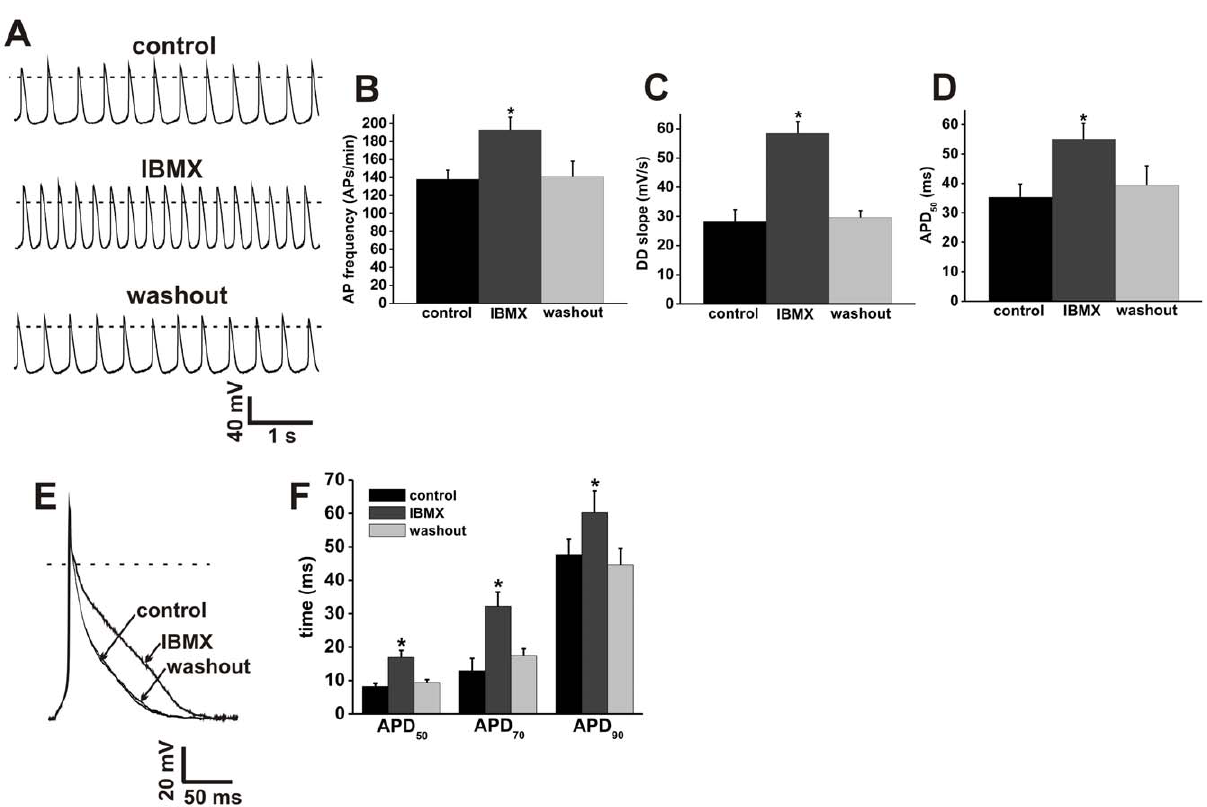
Figure 2. Effects of IBMX on action potential firing in SAN and atrial myocytes. A. Representative spontaneous AP recordings (5 s duration) in control conditions, in the presence of IBMX (100 m M) and after IBMX washout. Dotted lines are at 0 mV. Summary bar graphs illustrate the effects of IBMX on spontaneous AP frequency ( B ), DD slope ( C ) and APD 50 ( D ). E. Representative stimulated right atrial myocyte APs in control conditions, in the presence of IBMX (100 m M) and after IBMX washout. Dotted line is at 0 mV. F. Summary of the effects of IBMX on atrial AP duration (APD 50 , APD 70 , and APD 90 ). Summary data are means 6 SEM; n =11 SAN myocytes and 13 right atrial myocytes; * P , 0.05 vs. control by one way ANOVA with Tukey’s posthoc test. (Figure 2; Tables S1 and S2). IBMX increased ( P , 0.05)